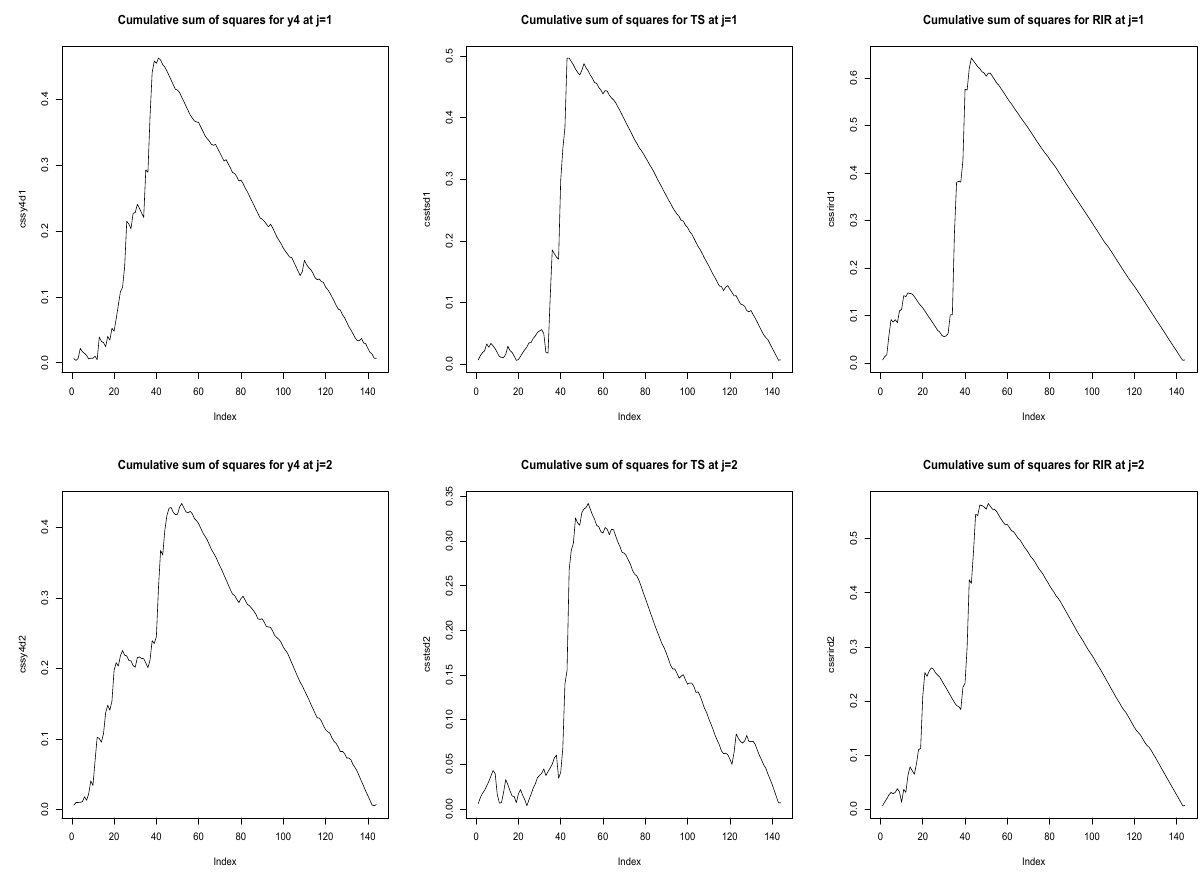
Figure 4. The auxiliary ˜ D test for j = 1 (upper panel) and j = 2 (lower panel) for output k (left), term spread (center) and real interest rate